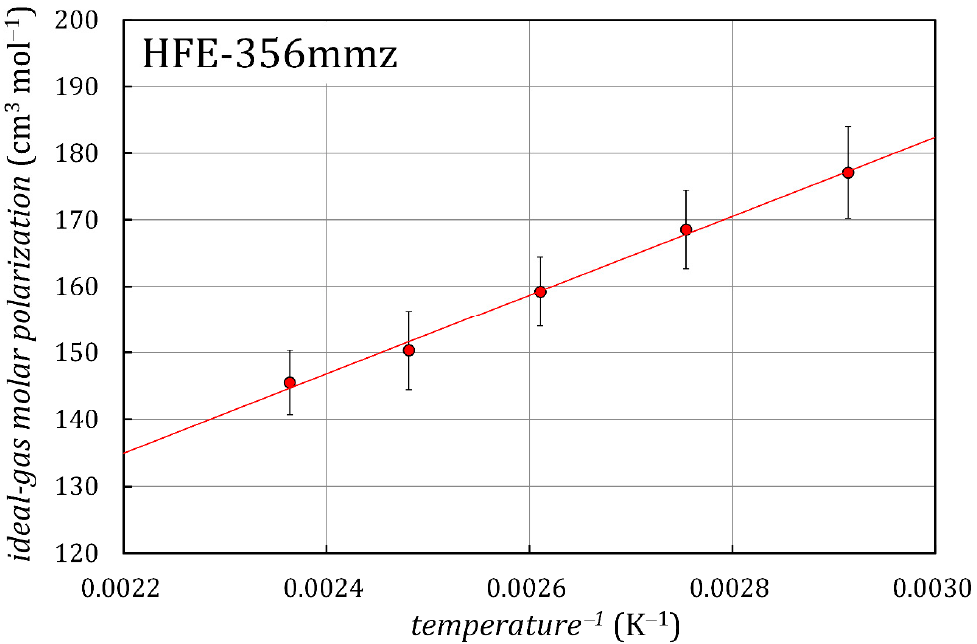
Figure 5. Inverse temperature dependence of the ideal-gas molar polarization data for HFE-356mmz.